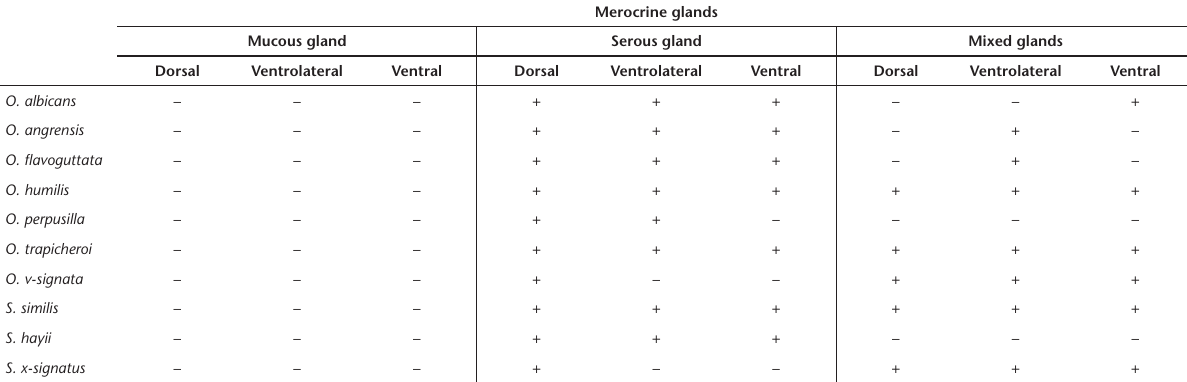
Table 3. Occurence of exocrine merocrine glands in the integument of Oloygon spp. and Scinax spp.